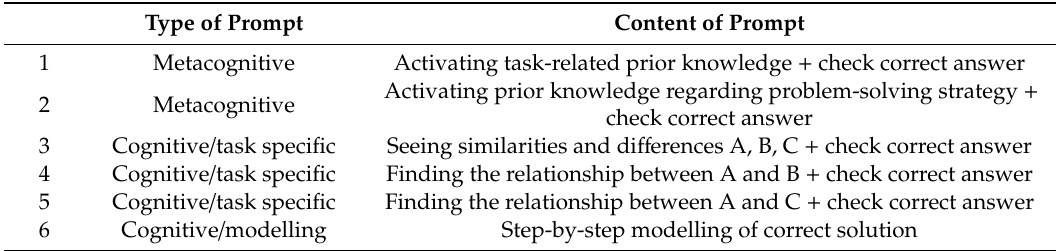
Table A1. Schematic overview of the graduated prompts training procedure.